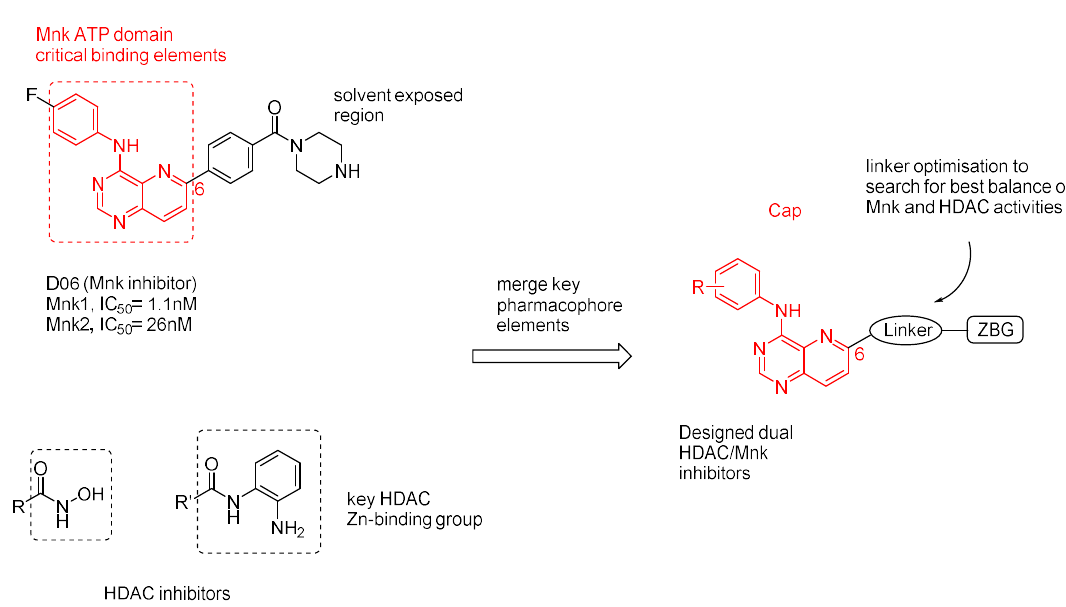
Figure 4. Design strategy of dual HDAC/Mnk inhibitors.